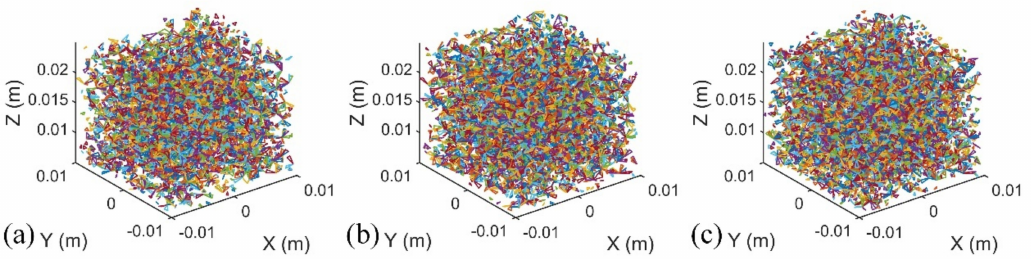
Figure 10. 3-cylces connection for the specimen FC40 at t = ( a ) 0.01 s; ( b ) 0.1 s; and ( c ) 0.2 s.